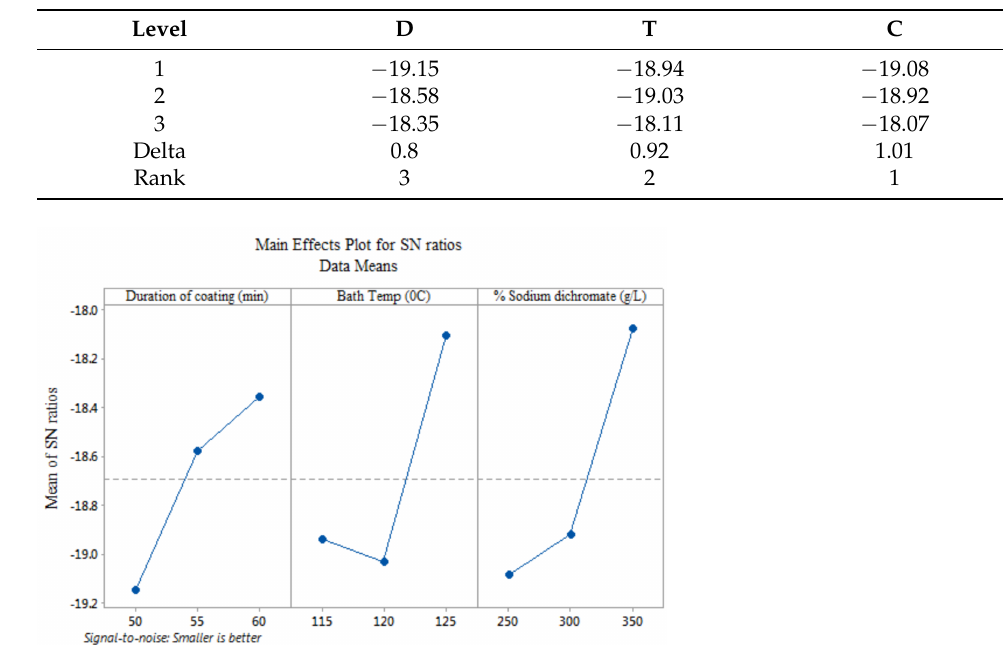
Table 3. Avg. S/N ratios for reflectance.